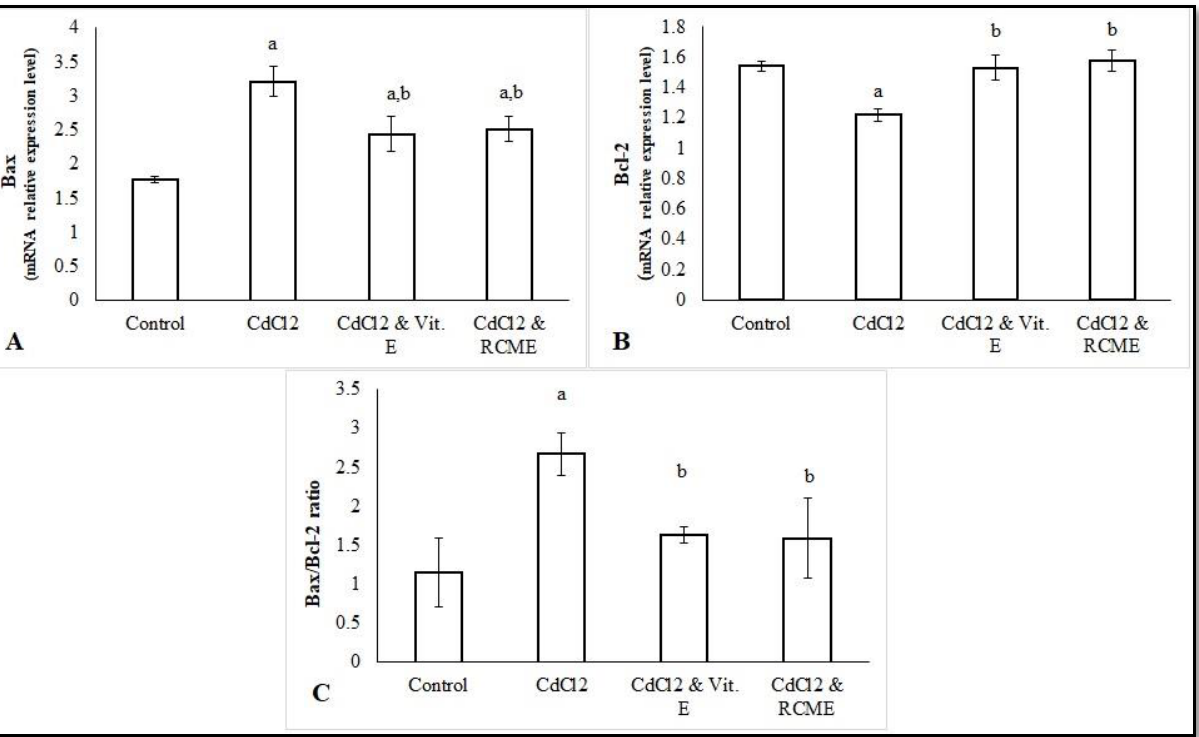
Figure 5. Mean values of the testicular mRNA relative expression levels of Bax ( A ), Bcl-2 ( B ) and Bax/Bcl-2 ratio ( C ) of control and treated rats. Each bar represents the mean ± SEM. a. p < 0.05 versus normal control. b. p < 0.05 versus CdCl 2 group. RCME: Red carrot methanolic extract; Vit. E: Vitamin E; Bcl-2, B-cell lymphoma 2; BAX, Bcl-2-associated X protein.